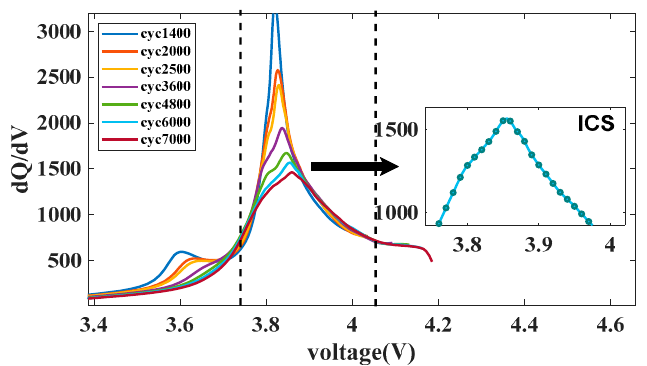
Figure 2. The incremental capacity curves of cell 1 in the Oxford dataset.